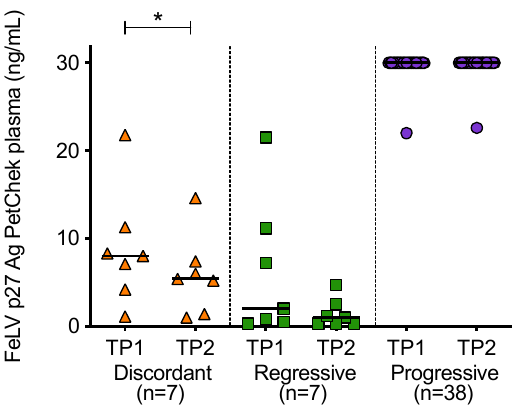
Figure 8. Plasma antigenaemia was measured using the IDEXX FeLV PetChek ® ELISA. Timepoint 1 (TP1) and timepoint 2 (TP2) p27 capsid antigen (Ag) concentrations were compared within each of the exposure outcome groups. Statistical significance was determined using Wilcoxon matched-pairs signed rank test ( p -value < 0.05 *).